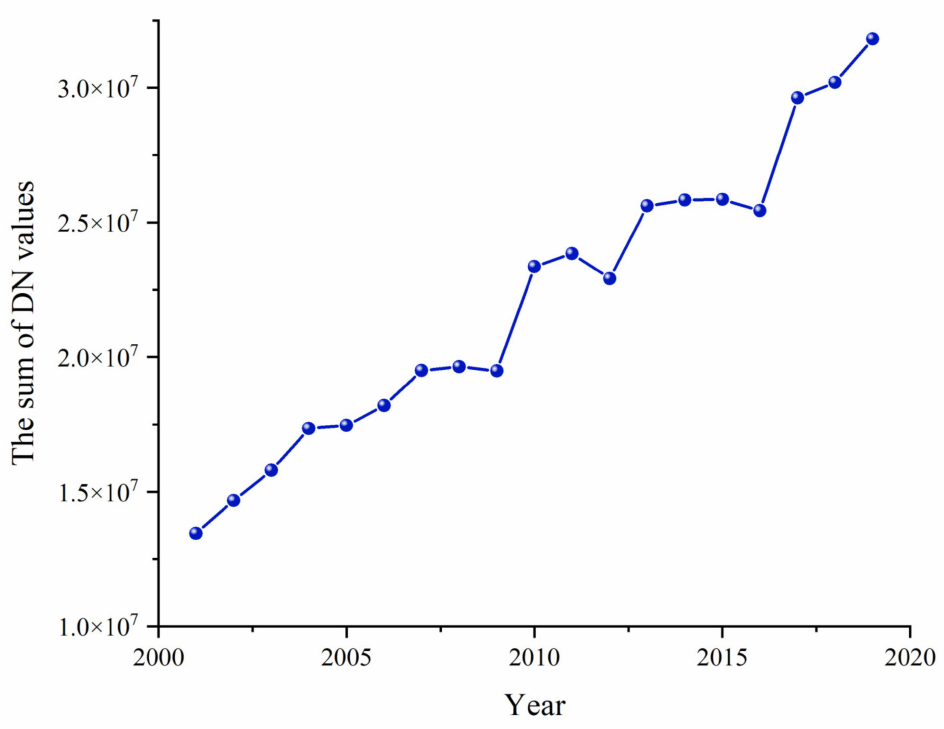
Figure 4. Sum of DN values in China from 2001 to